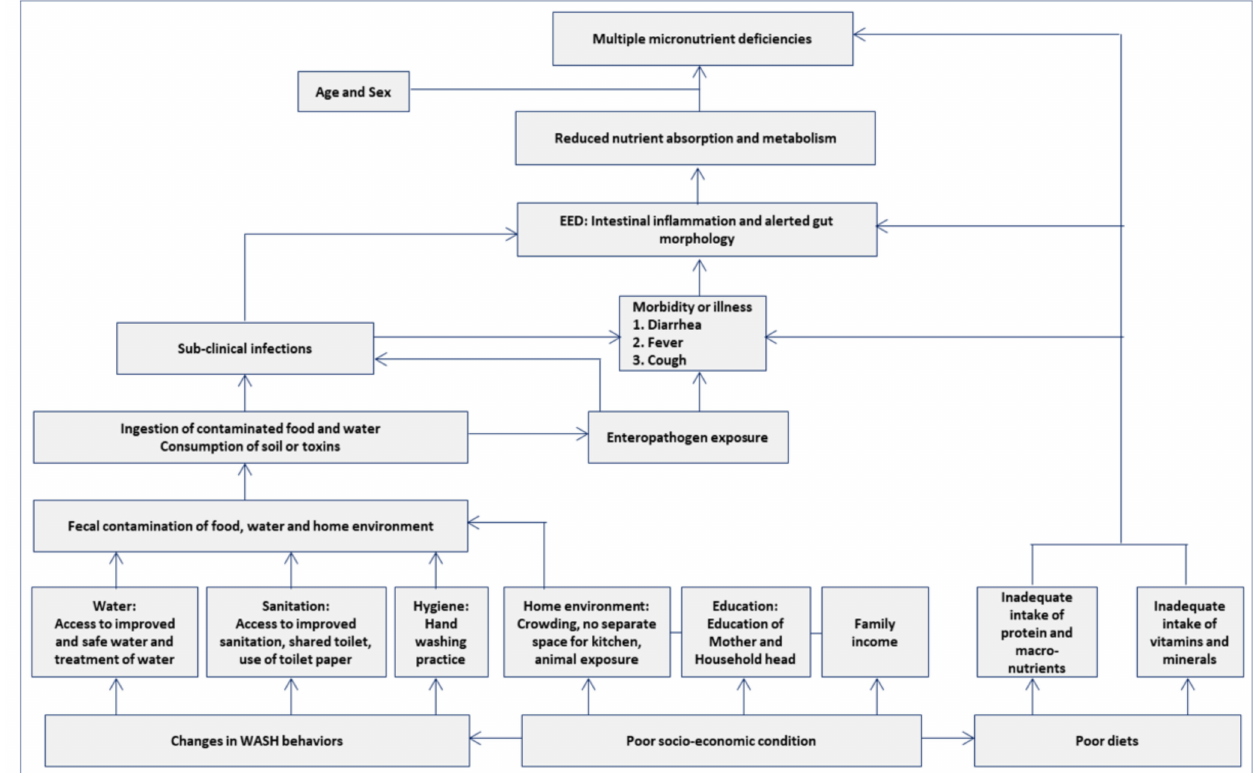
Figure 1. Conceptual